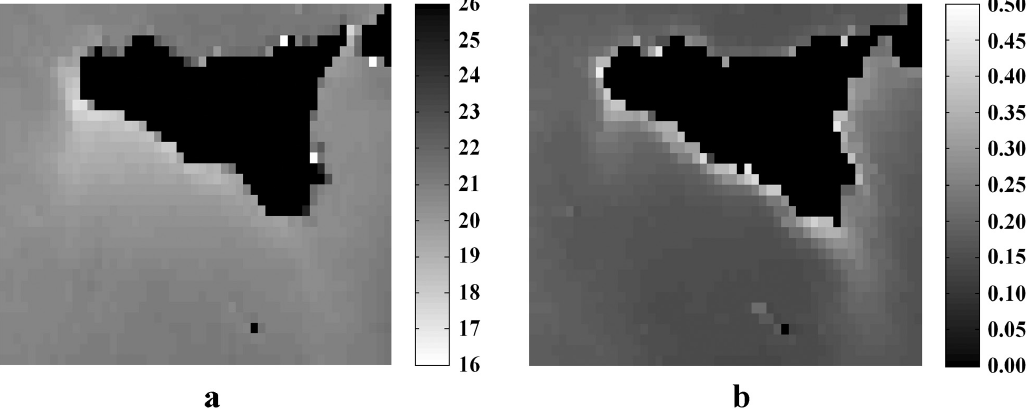
Fig . 2. – Climatologies of: (a) SST (degree C), and (b) Chl a concentration (mg m -3 ) over the study area, obtained respectively from the AQUA MODIS mission (period: January 2002 - February 2008) and the SeaWiFS mission (period: September 1997 to December